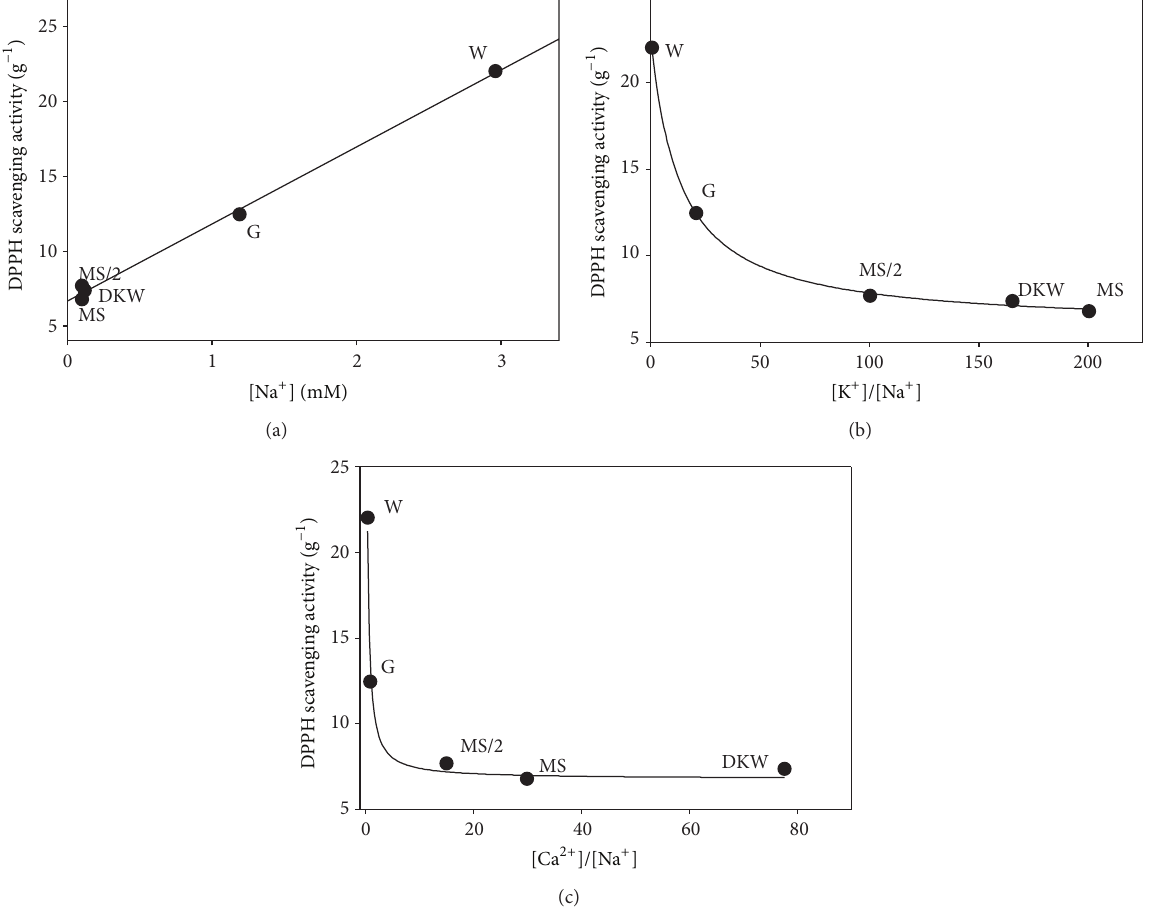
Figure 2: (a) Relationship between initial Na + concentrations present in the basal media formulations used in this study and antioxidant activity displayed by C. heterophyllus extracts after 4 weeks of culture in liquid media. In (b) and (c) DPPH scavenging activity versus K + /Na + and Ca 2+ /Na + ratios, respectively, is